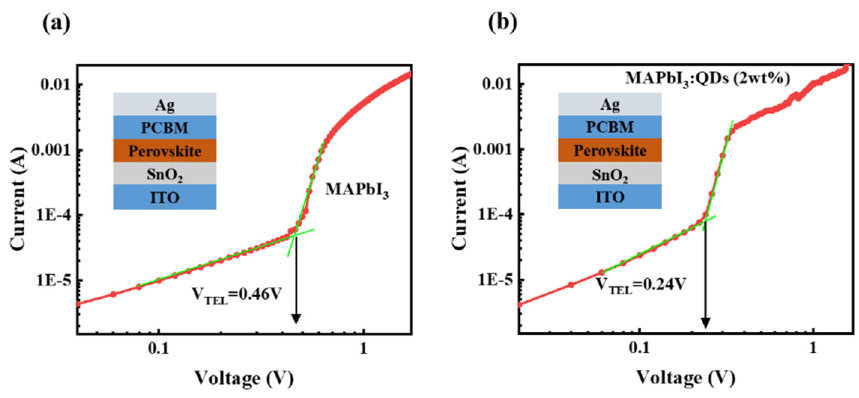
Figure 5. J-V characteristics under dark conditions of electron-only devices containing the perov- skite film ( a ) without and ( b ) with CsPbI 3 QDs.